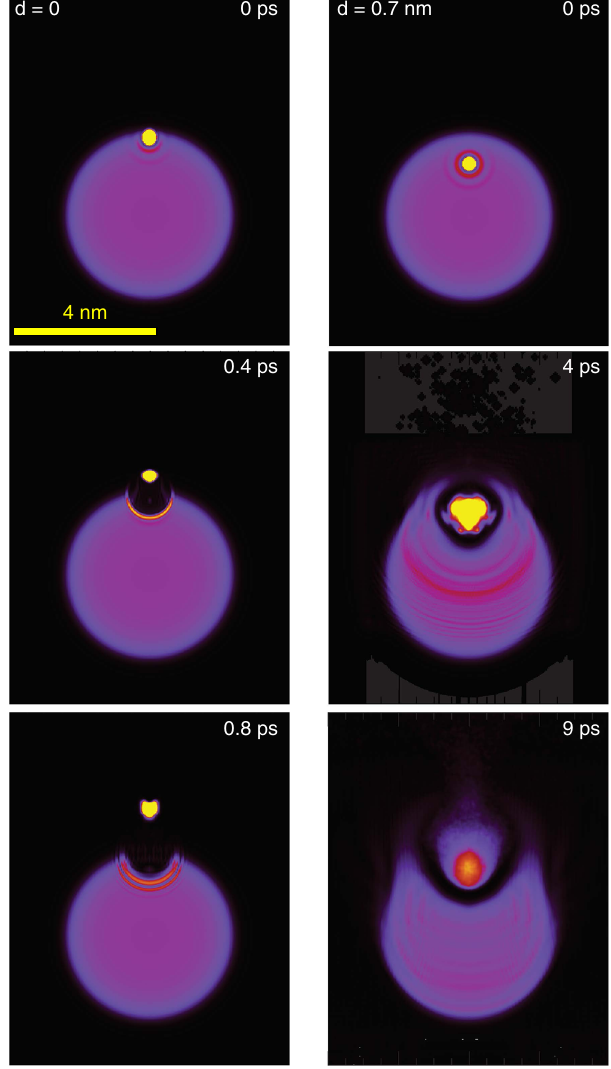
Fig. 3 Evolution of the He density distribution. In this simulation, the probability distribution of He (cid:1) is represented as a yellow dot. The initial position of He (cid:1) is 0 (left column) and at 0.7 nm (right column) away from the droplet surface.